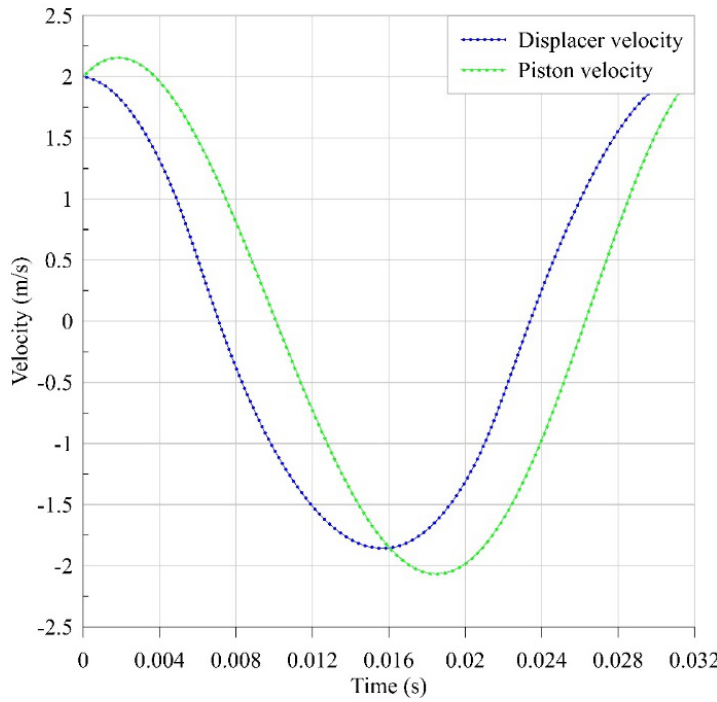
Figure 4. Displacer and piston velocity.